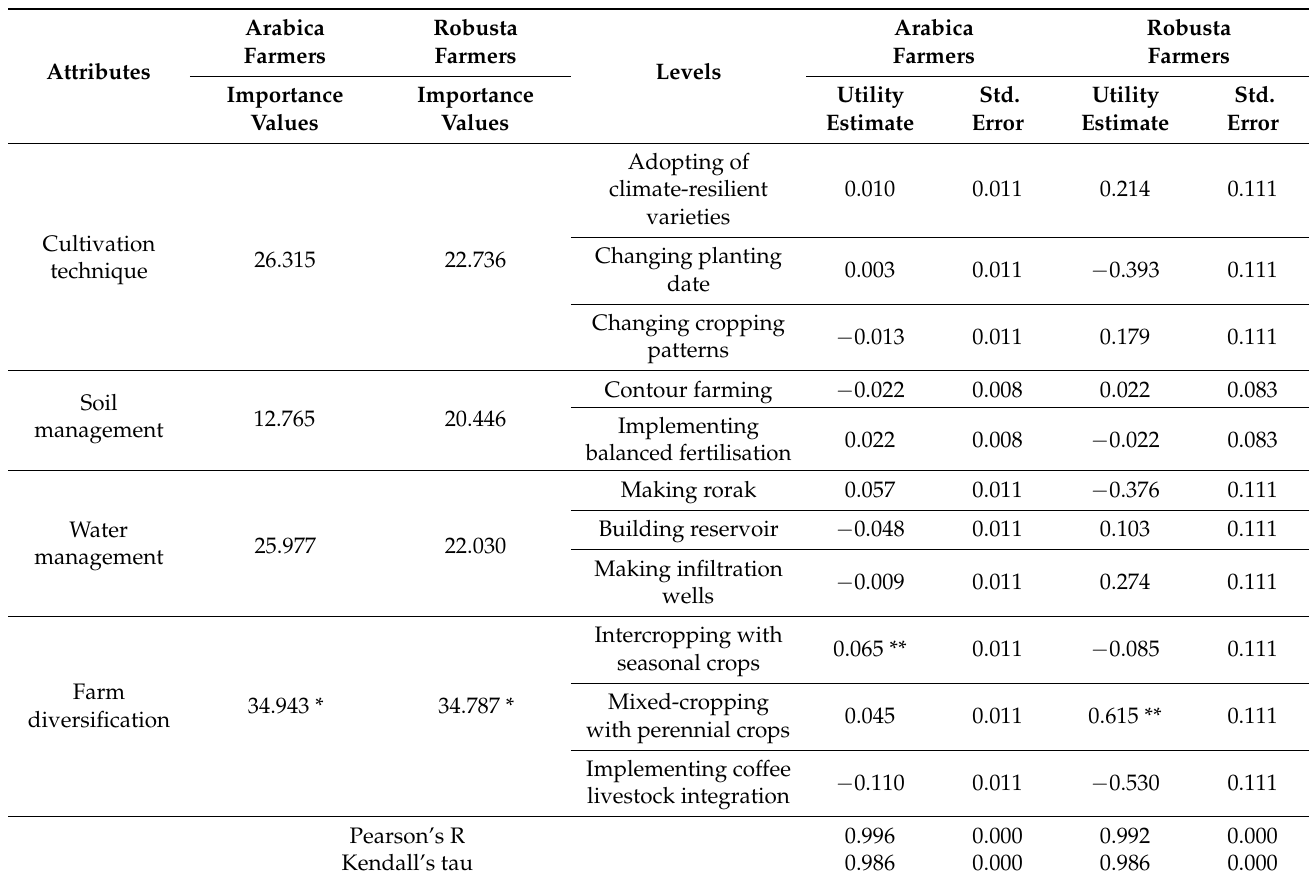
Table 5. Statistics analysis of farmers’ preferences in CSA